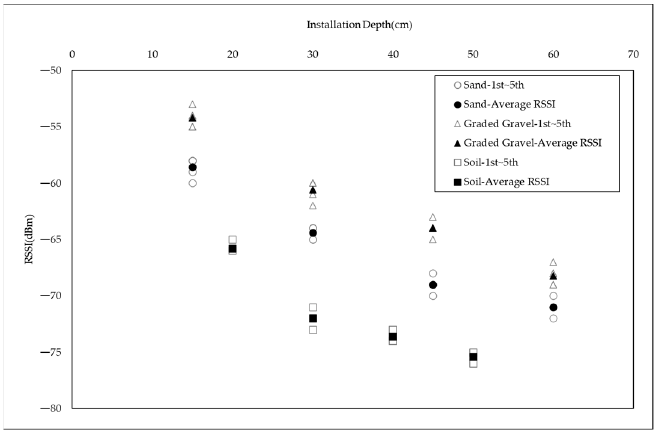
depths were − 54.2 dBm and − 68.2 dBm, respectively.